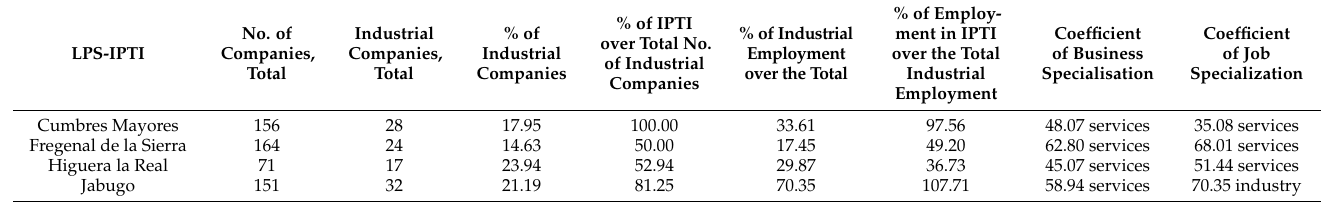
Table 9. Employment specialisation in the LPS-IPTI (December 2019).